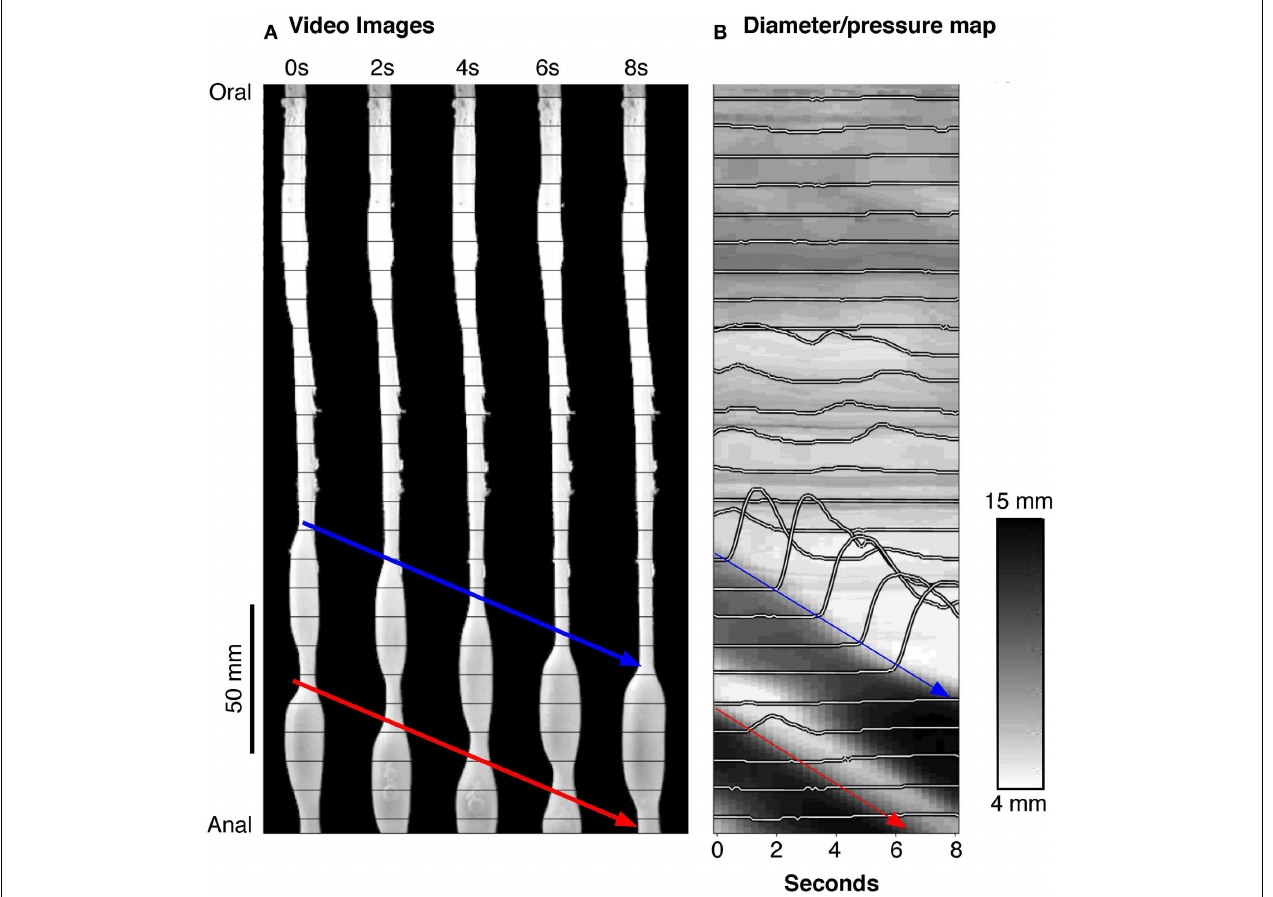
FIGURE 1 | (A) A series of silhouettes of the rabbit colon taken at 2s intervals during the movement of a bolus. The thin horizontal lines indicate the location of the fiber-optic pressure sensors (at 10mm intervals). (B) A spatiotemporal diameter map (DMap) created from the same 8s period with the multichannel intraluminal pressure traces (recorded by the fiber-optic